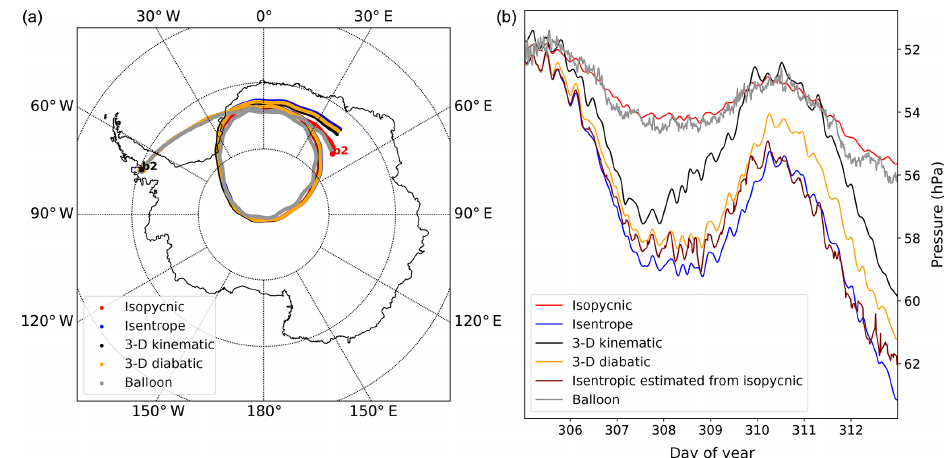
Figure 2. (a) Observed and calculated 8d horizontal trajectories of Vorcore Balloon 2 starting from its position on 2 November 2005 at 00:00UTC. The calculated trajectories are 3D kinematic (with omega velocity, black), 3D diabatic (with diabatic heating rates, orange), 2D isentropic (blue) and 2D isopycnic (red) trajectories; all were computed using the ERA5 wind and temperature field at 3-hourly output resolution. The observed trajectory of the balloon is shown in gray. (b) Pressure time series corresponding to the horizontal trajectories in (a) . Please note that the y scale only covers a narrow range of altitudes (roughly 1km maximum deviation peak to peak, i.e., about three model levels for